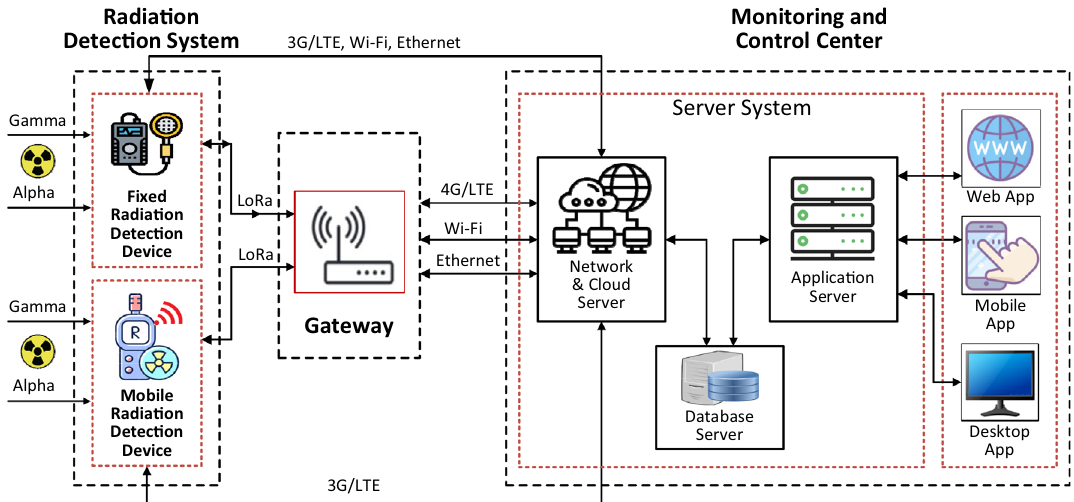
Figure 1. Architecture and components of the IoT based radiation sensor system